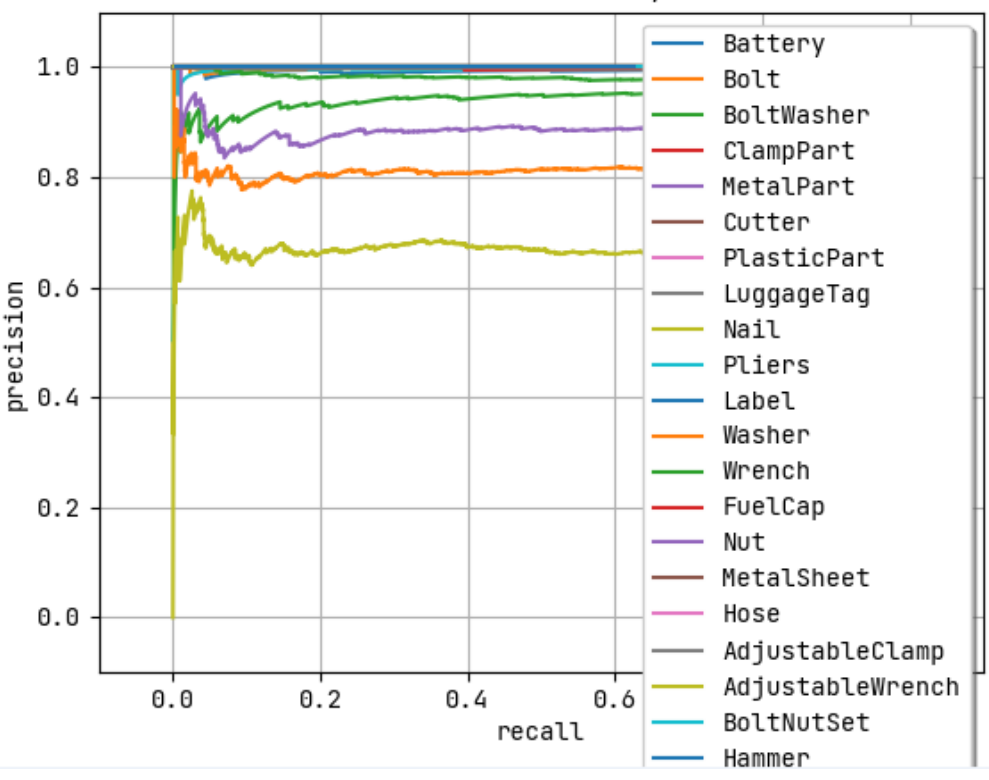
Figure 6. Precision vs. recall curve.